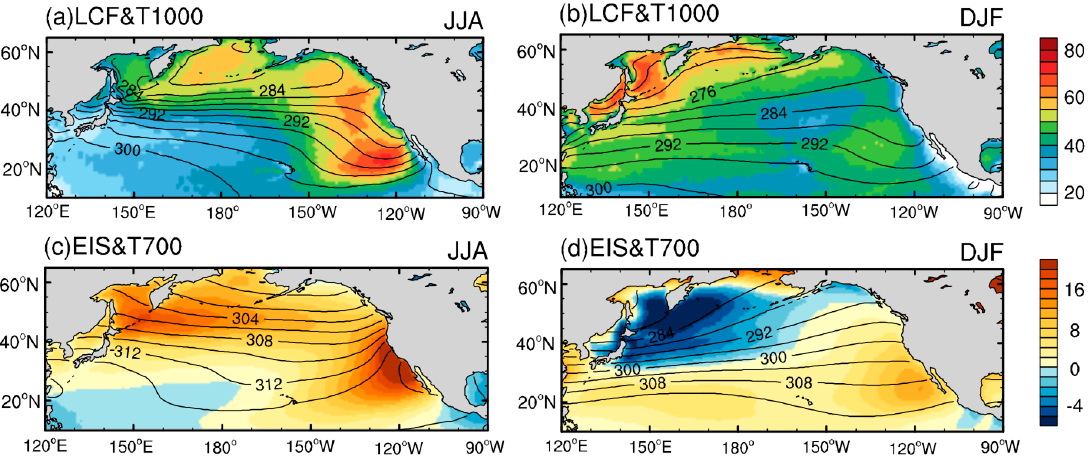
Figure 1. Climatological low-cloud fraction (LCF; shading; units: %) and surface potential temperature (contour interval: 2 K) in summer ( a ) and in winter ( b ); ( c , d ) are the same as ( a , b ), but for estimated inversion strength (EIS; shading; units: K) and 700-hPa potential temperature (contour interval: 4 K).